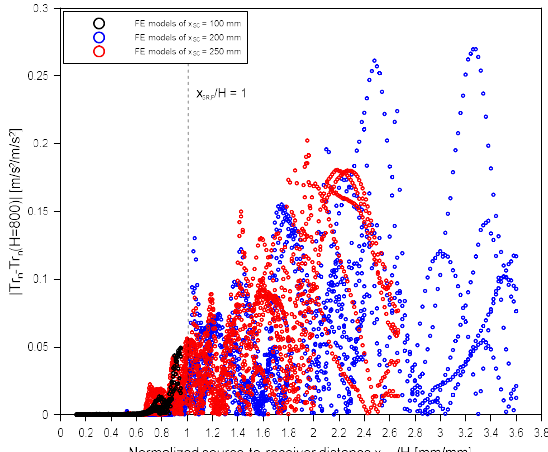
Figure 9. Variation of normalized transmission coefficient of surface waves, Tr n , in the FE models with various plate thicknesses ( H = 150, 200, 300, 400, and 800 mm), with respect to two relative sensor locations (normalized source-to-receiver distance, x SR /H and normalized receiver-to-crack distance, x RC / λ R ) at the two frequencies : ( a ) f c = 15 kHz, and ( b ) f c = 25 kHz.